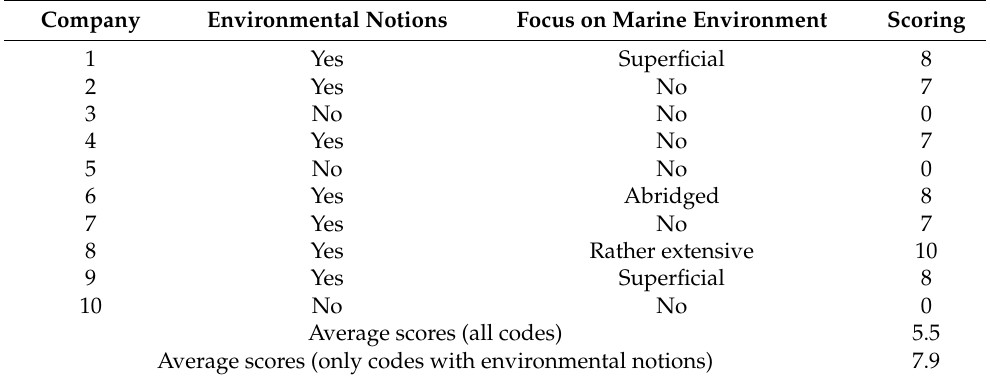
Table 3. Environmental assessment of the analyzed codes of conduct.